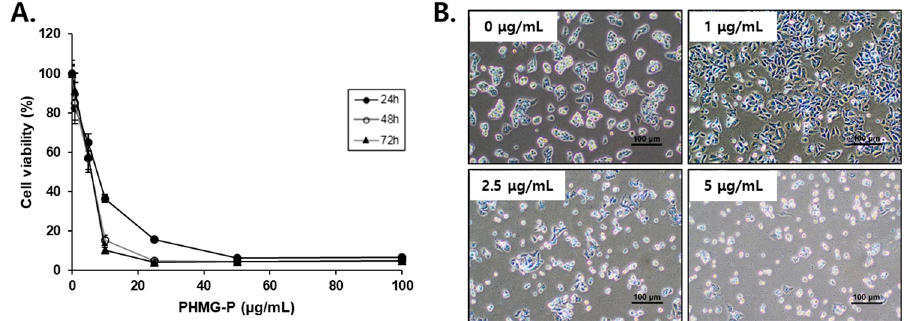
Figure 1. ( A ) The effect of polyhexamethyleneguanidine phosphate (PHMG-P) on HepG2 cell viability. The cells were treated with increasing concentrations of PHMG-P for 72 h, and then 3-(4,5- dimethylthiazol-2-yl)-2,5-diphenyltetrazolium bromide (MTT) assays were performed to measure the cell viability. The cell viability (%) is expressed as a percentage of the viability of vehicle-treated cells, and the data are presented from three independent experiments. Each value represents the mean ± SD. ( B ) The morphological changes in HepG2 cells after the treatment with PHMG-P for 24 h.